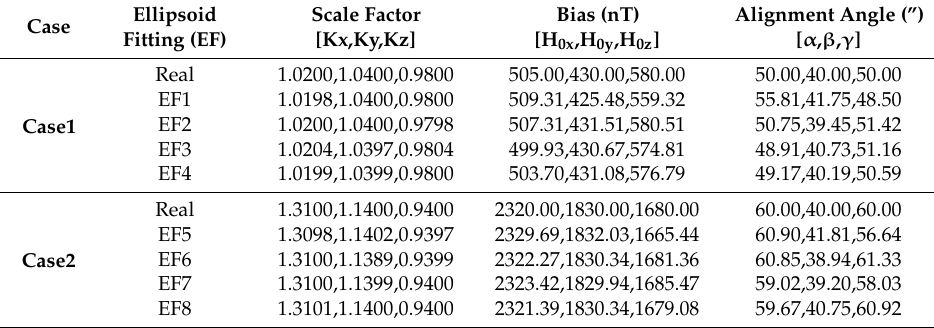
Table 2. Calibration